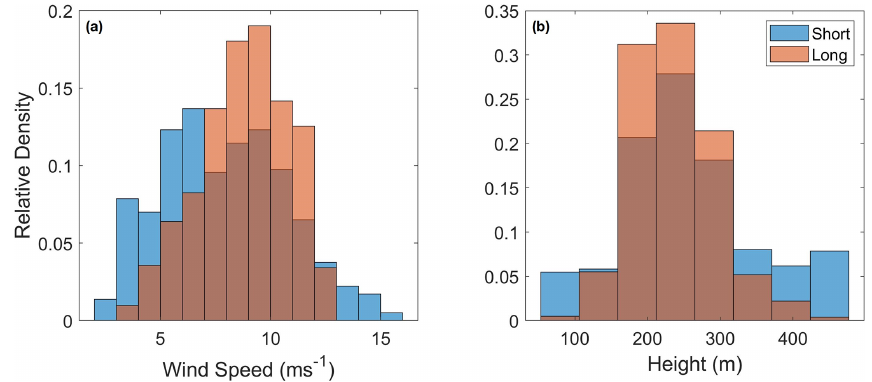
Figure 8. Frequency of NLLJ core wind speeds (a) and heights (b) in Falkenberg during short ( ≤ 3h) and long events ( > 3h).